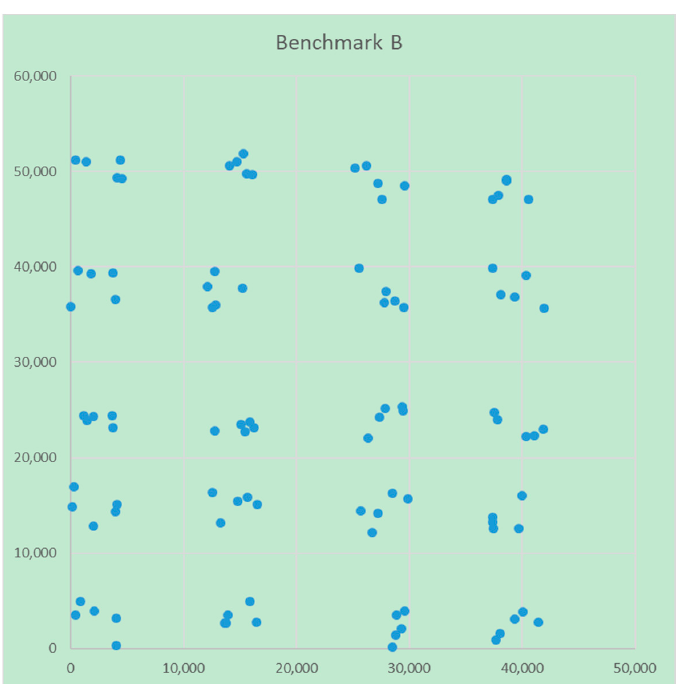
Figure 2. Benchmark instance B. For benchmark C, values of positions of points are generated by the Excel RANDBE- TWEEN function in the range 0 to 45,000 for x coordinate, range 0 to 60,000 for y coordinate, for weight in range 1 to 25 (Figure 3). For benchmark C, the reference solution is cal- culated using the metaheuristic method: the lowest value of 300 calculations on three HW configurations is used. Table 4 shows the reference values for the benchmark instances.